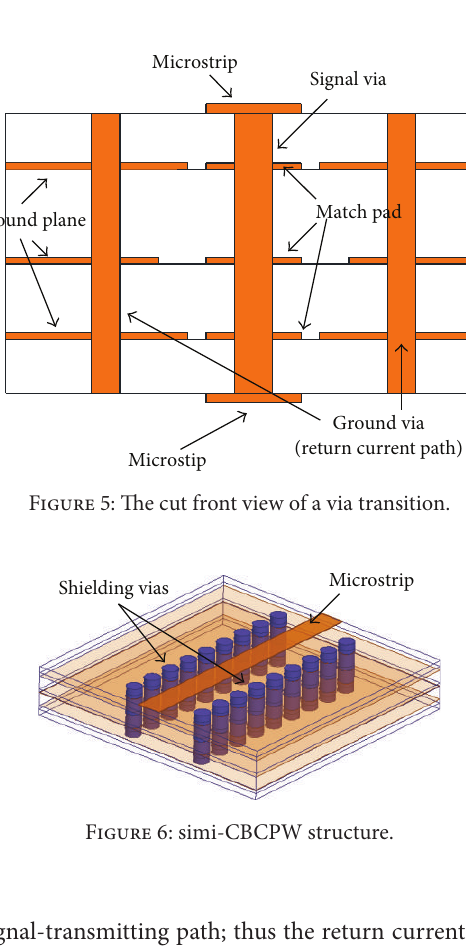
Figure 4: Top view of matching pads loaded transition. (a) The first layer; (b) the first ground plane.